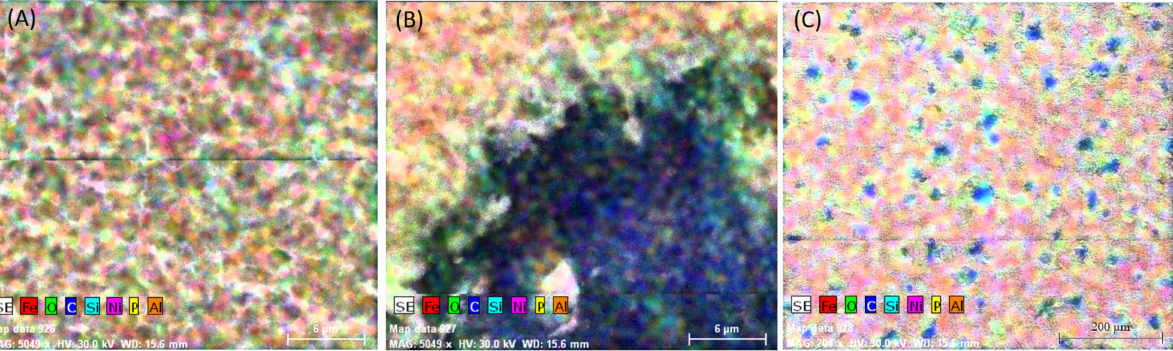
Figure 9. Elemental distribution of the areas presented in Figure 8: ( A ) Zone A, ( B ) Zone B and ( C ) Zone C.